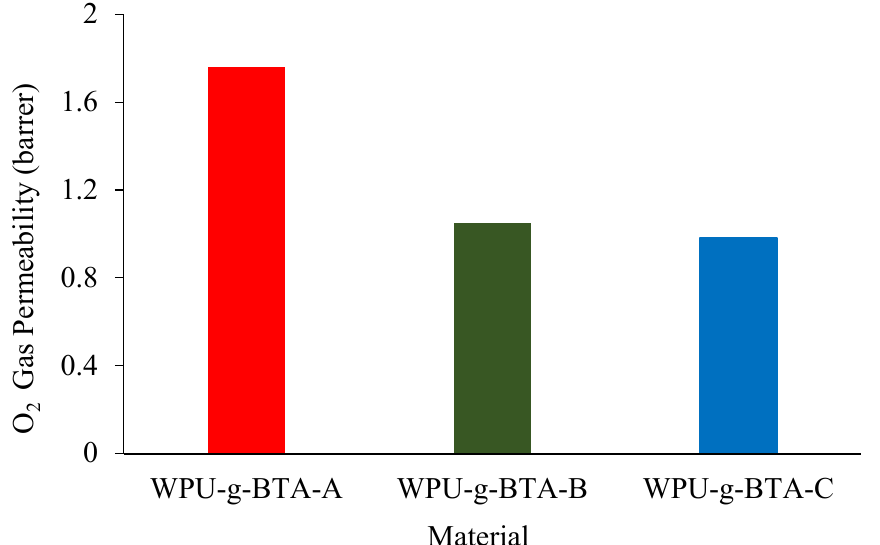
Figure 9. O 2 permeability for CRS electrode coated with (red) WPU − g − BTA − A, (green) WPU − g − BTA − B, and (blue) WPU − g − BTA − C.